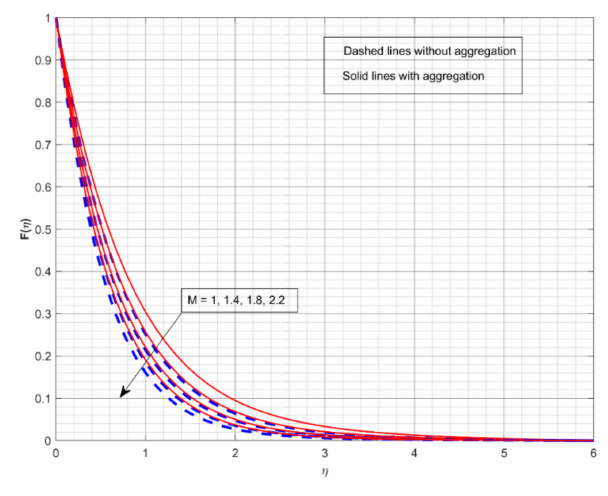
Figure 2. The impact of magnetic parameter on the velocity profile F ( η ) .